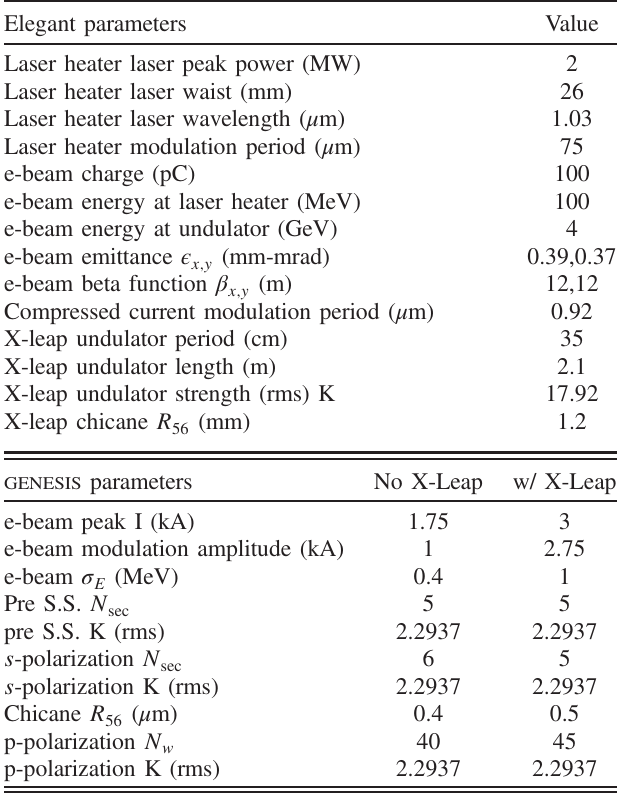
II. Parameters for start-to-end